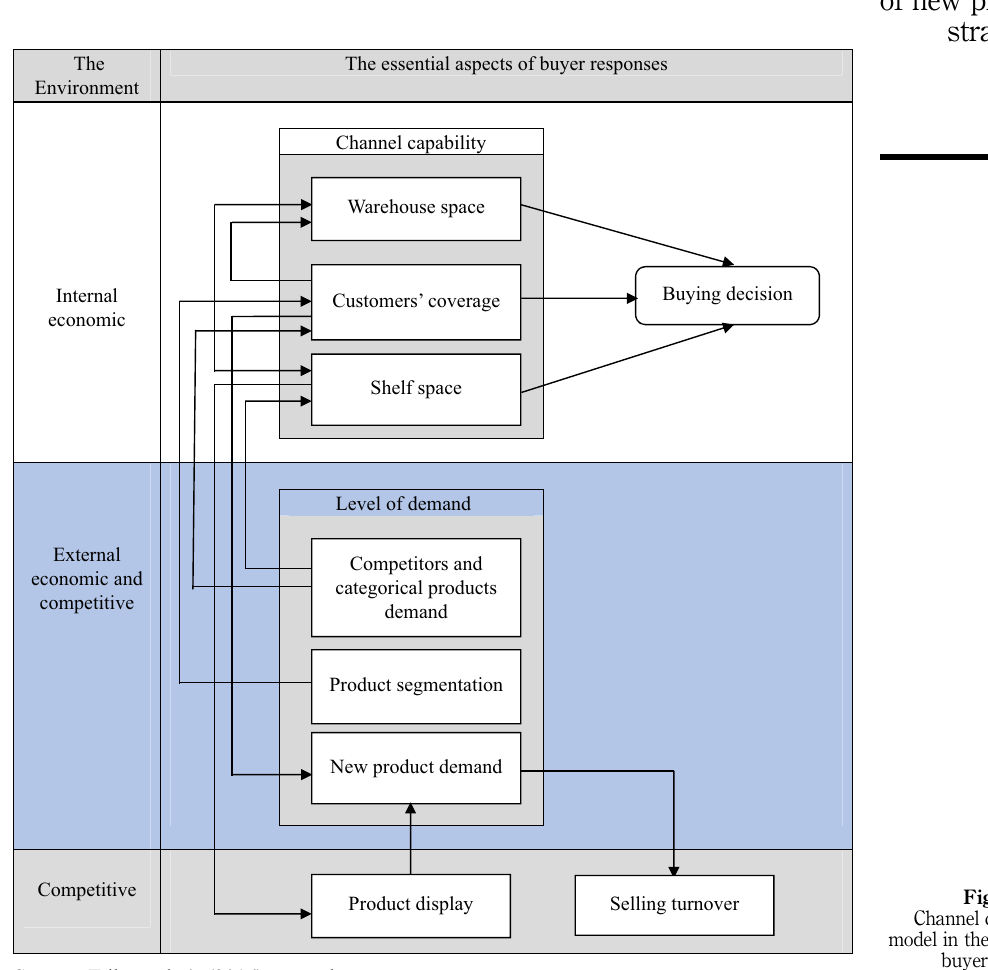
Figure A1. Channel